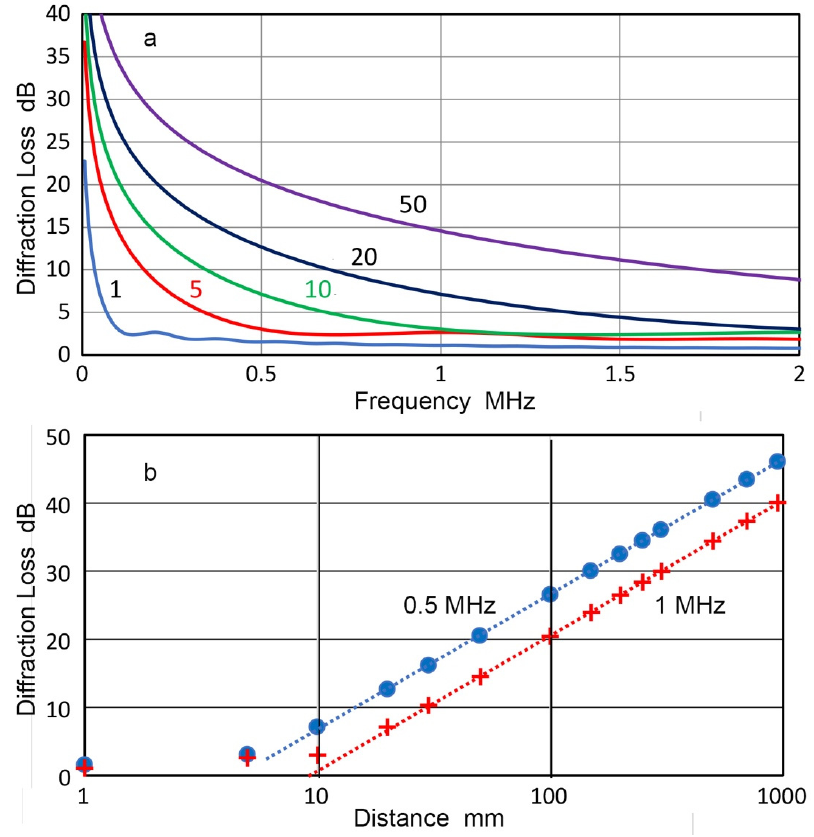
Figure 7. ( a ) Diffraction loss, |D( f )| (dB), vs. frequency, f (MHz) for five values of distance, x (mm). Curves for x = 1, 5, 10, 20 and 50 mm are in blue, red, green, black and purple. ( b ) Diffraction loss, |D| (dB), vs. distance, x (mm) for f = 0.5 MHz (blue dot) and 1 MHz (red +). A linear fit is shown by dotted lines.